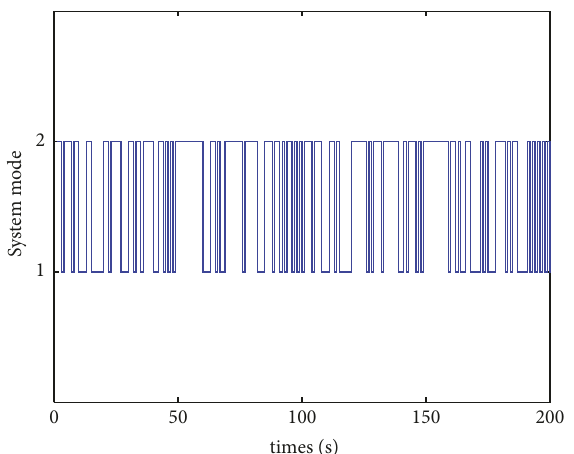
Figure 1: The switching between two modes.